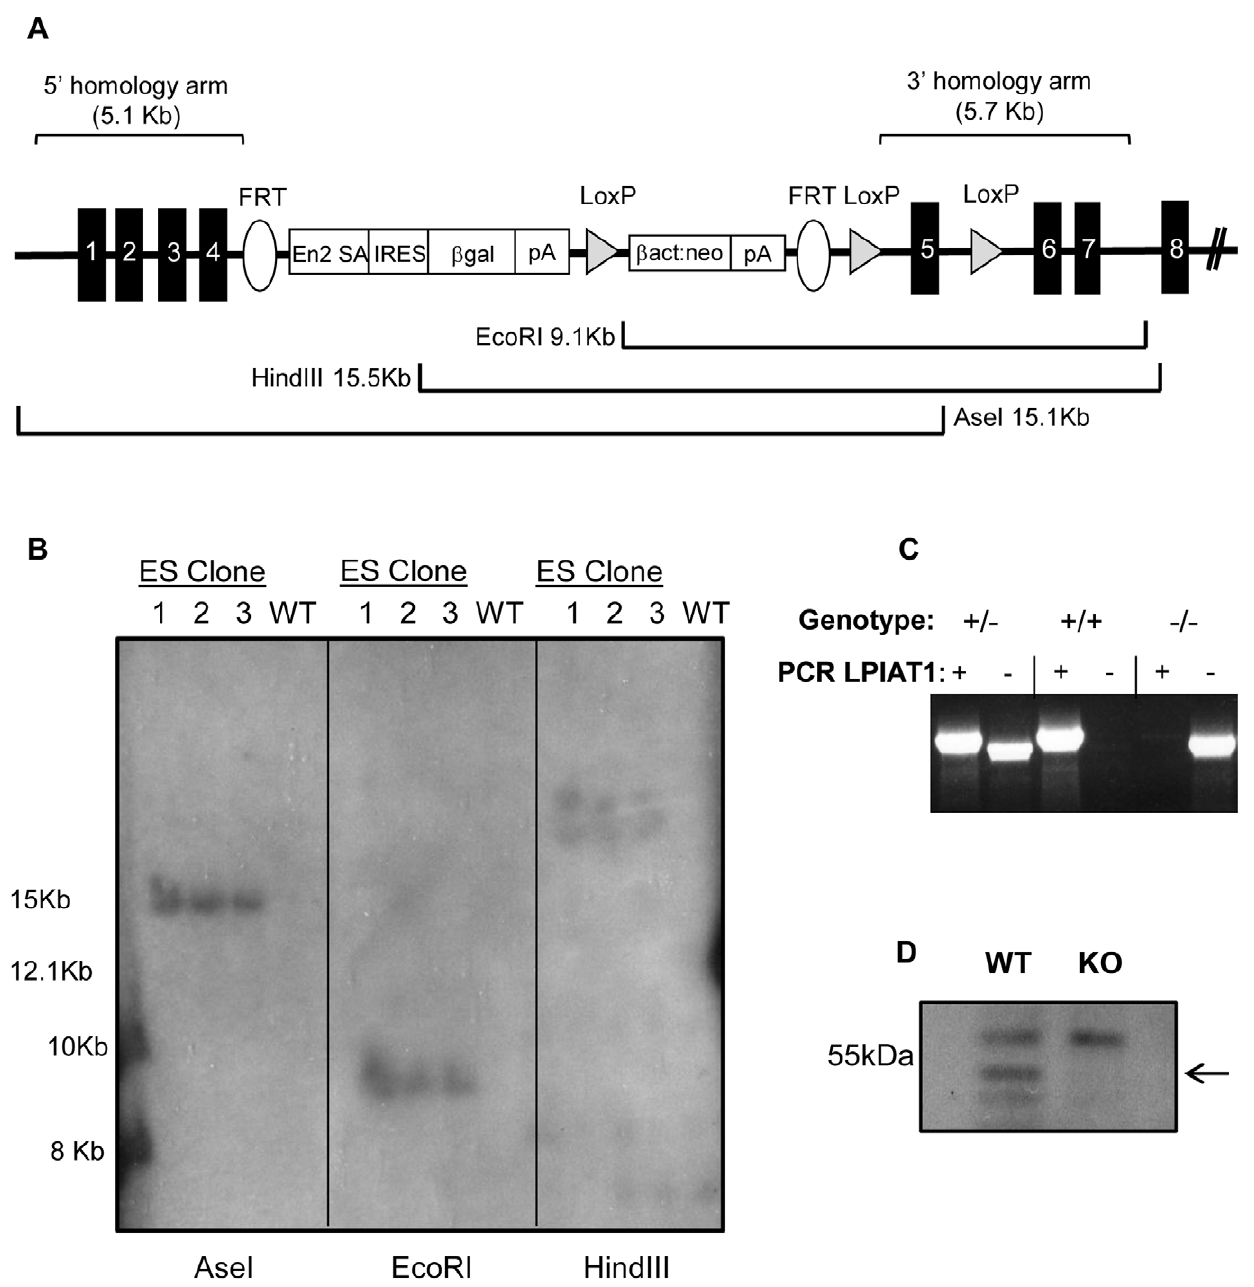
Figure 1. Generation of LPIAT1 knockout first mice. ( A ) Schematic representation of LPIAT tm1a(KOMP)Wtsi gene targeting vector, constructed by the High throughput gene targeting group at the Sanger Center as a ‘knock-out first’ allele that abrogates expression of the targeted allele. Shown are expected enzymatic digest fragments for EcoRI, HindIII and AseI digests of the correctly targeted allele, which were confirmed by Southern analysis of three ES cell clones and WT BL6 genomic DNA control using a [ 32 P]-oligonucleotide probe to a 600bp region of the Neomycin gene within the targeting cassette ( B ). ( C ) Genotyping of mice was performed by PCR amplification to identify the presence of LPIAT1 WT allele ( + ) and/or targeted KO allele ( 2 ) from LPIAT1 + / 2 , LPIAT1 + / + and LPIAT1 2 / 2 mice. ( D ) Western blot analysis was performed on 50 m g wet weight brain tissue from three pairs of LPIAT1 + / + (WT) and LPIAT1 2 / 2 (KO) 13 day old littermates as described in Materials and Methods. Shown is a representative immunoblot, with the arrow indicating the position of LPIAT1